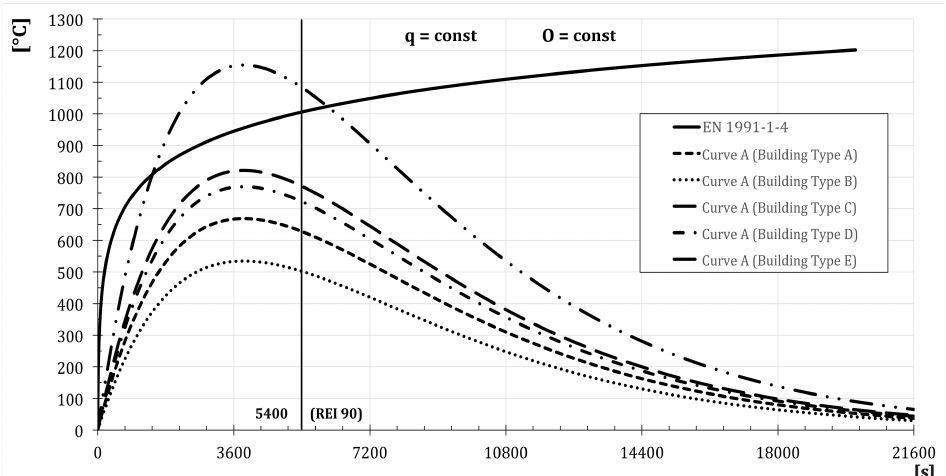
Figure 5. Trend of the temperatures with respect to time (q = 233.6 MJ m − 2 ; O = 0.0289 m 0.5 ) based on the prescriptive approach (EN 1991-1-2) and the simplified performance-based approach (Equation (3): “Curve A”) changing with the variation in the building (Table